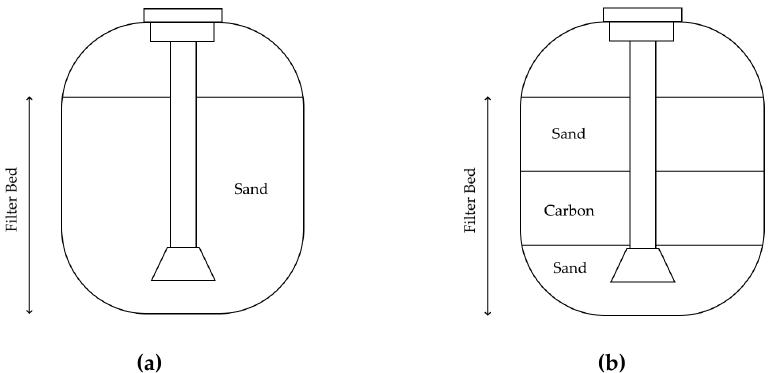
Figure 3. Schematic diagrams depicting the ( a ) sand and ( b ) the sand + carbon filtration systems.